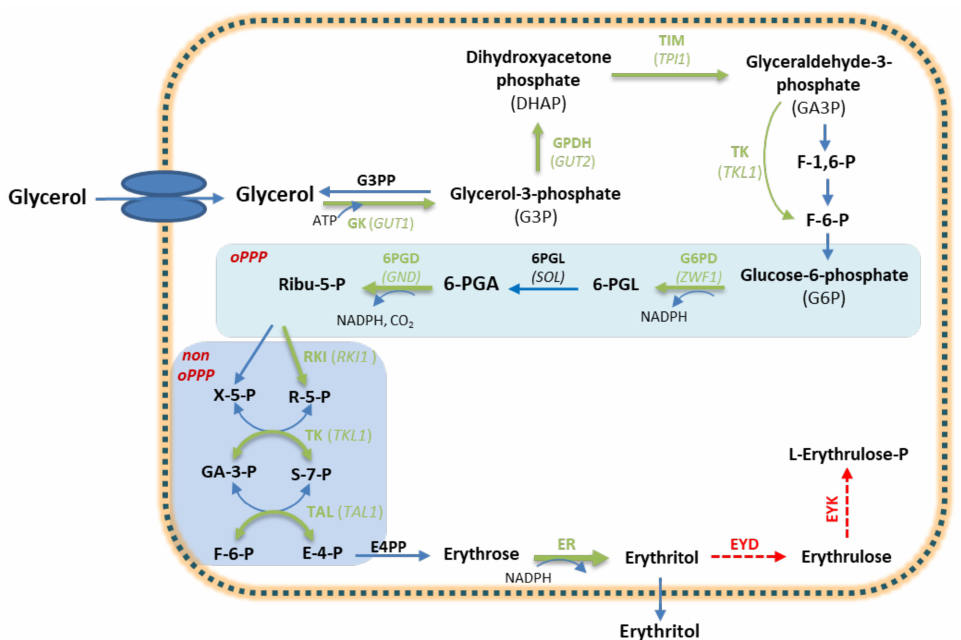
Figure 2. Biosynthetic pathway of erythritol in Y. lipolytica using glycerol. The enzymes encoded by corresponding genes are listed as follows: G3PP, G3P phosphatase; GK, glycerol kinase ( GUT1 );